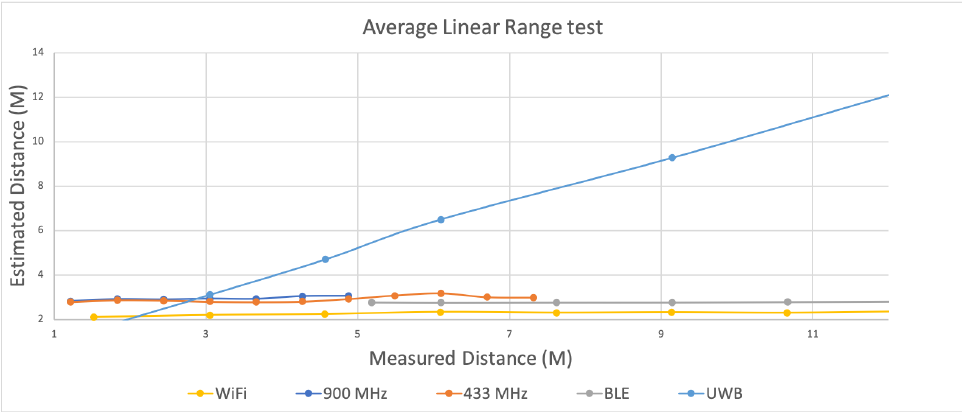
Figure 12. Linear distance estimates relative to measured distance between two devices comparing, BLE, 433 MHz, 915 MHz, Wi-Fi, and Ultra-Wide